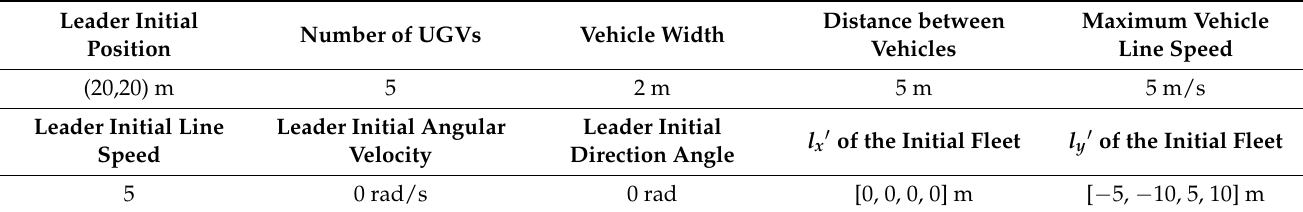
Table 1. The relevant parameters in the formation controller test.